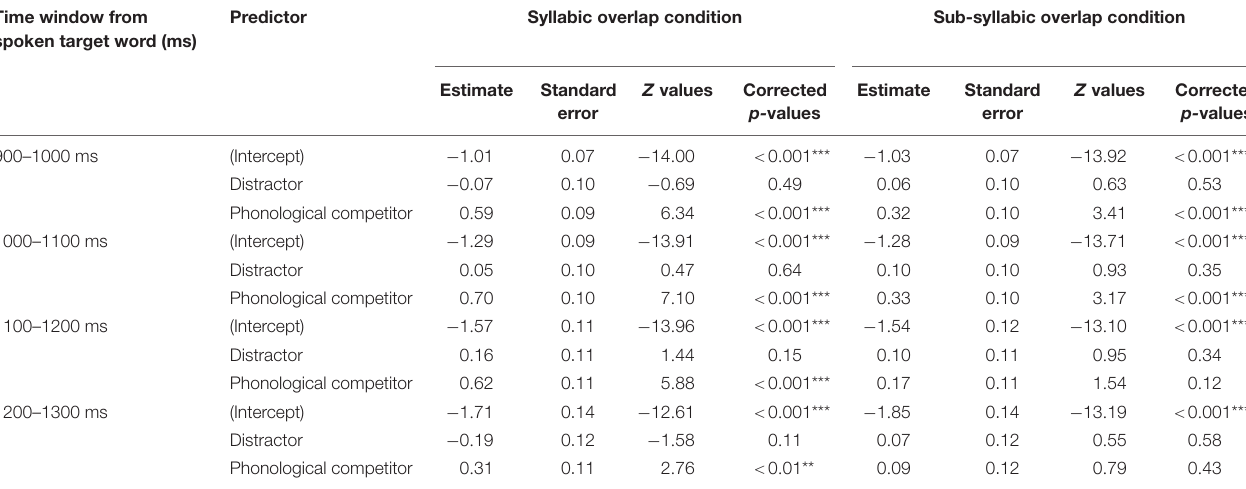
TABLE 2 | Time windows analysis for results of logit mixed models in the syllabic overlap and sub-syllabic overlap conditions in Experiment 2. Time window from spoken target word (ms)